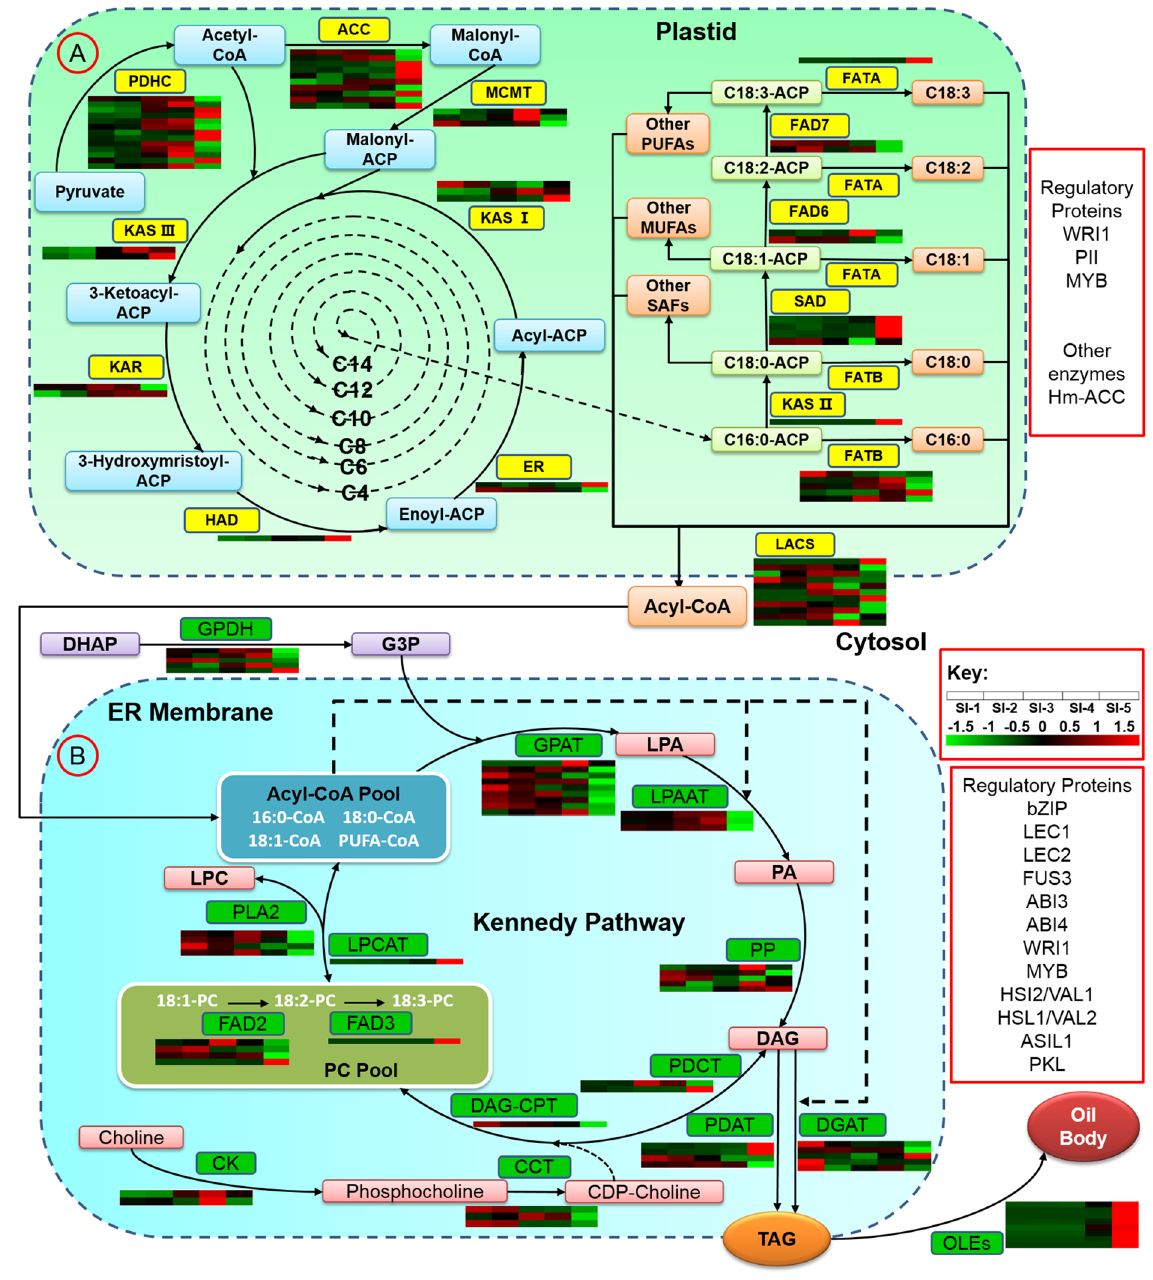
Figure 7. Identification of genes in the pathways of fatty acid synthesis ( A ) and triacylglycerol synthesis ( B ), based on the transcriptome of P. volubulis seeds—the icons below each enzyme ID show the expression patterns of the transcripts through each of the five seed developmental stages, with the color scale indicating the level of expression of unigenes: deeper red indicates higher expression while greener colours represent lower expressions. Note: expression patterns are shown only for unigenes that were found to have RPKM values of ≥